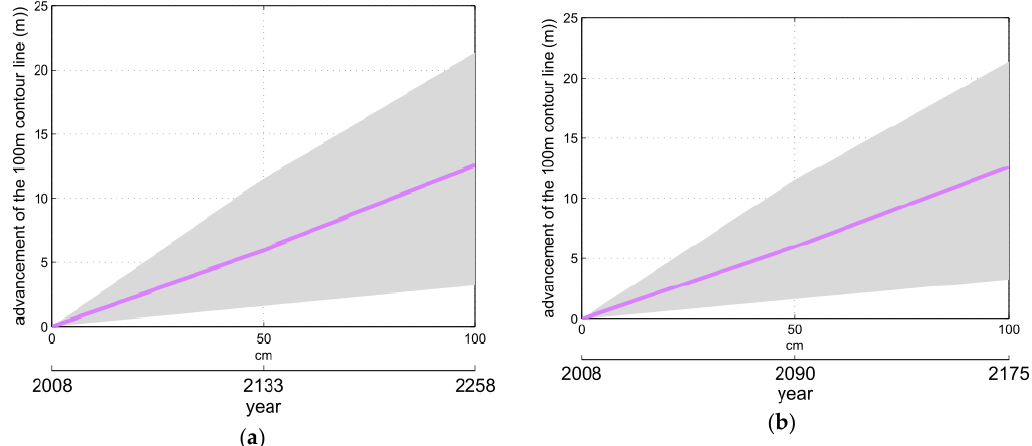
Figure 8. Advancement inland of the 100 m contour line of the seawater/freshwater interface with respect to sea level rise and years: ( a ) 4 mm per year, ( b ) 6 mm per year.